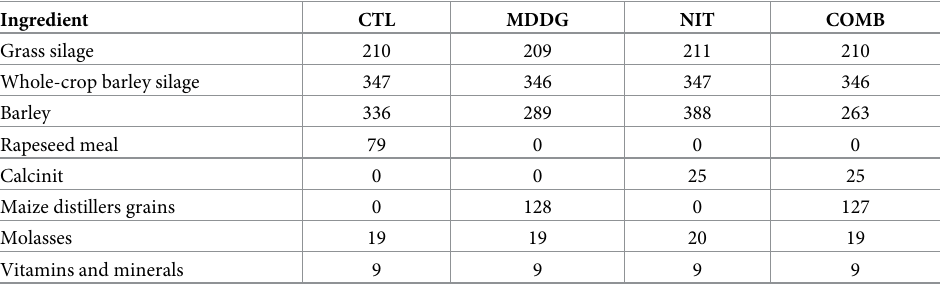
Maize distillers grains Vitamins and